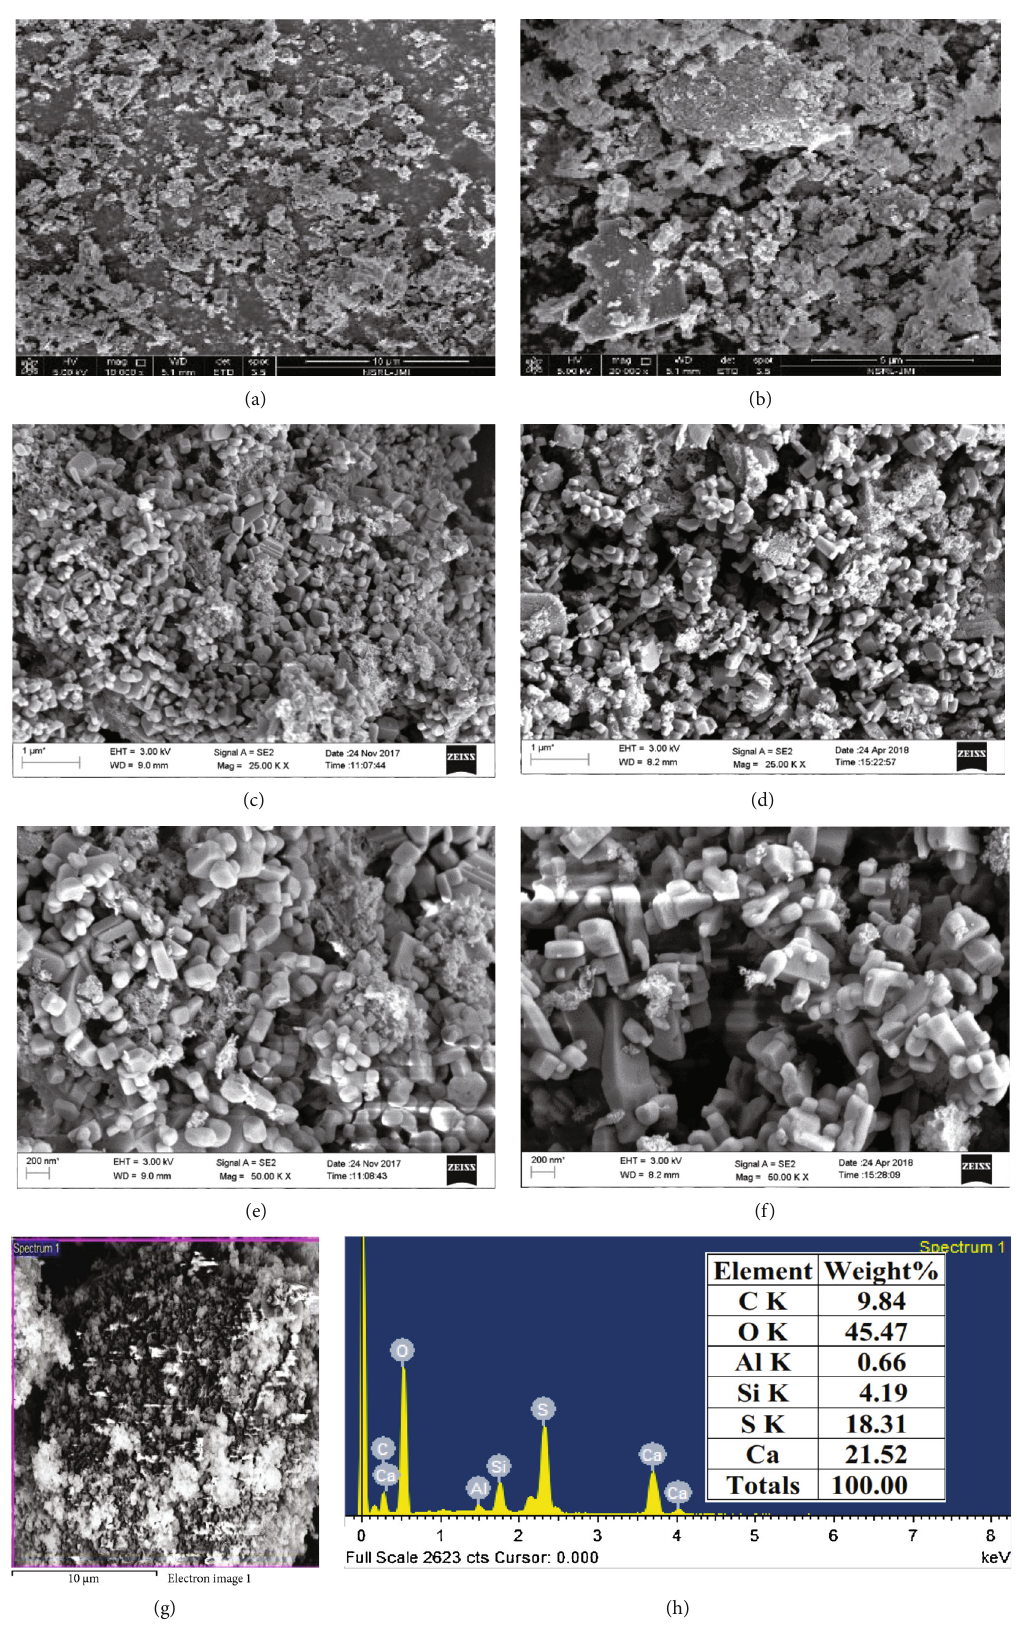
Figure 6: FESEM images of (a, b) incense stick ash, (c – f) calcium-rich zeolites, (g) EDS spot, and (h) EDS